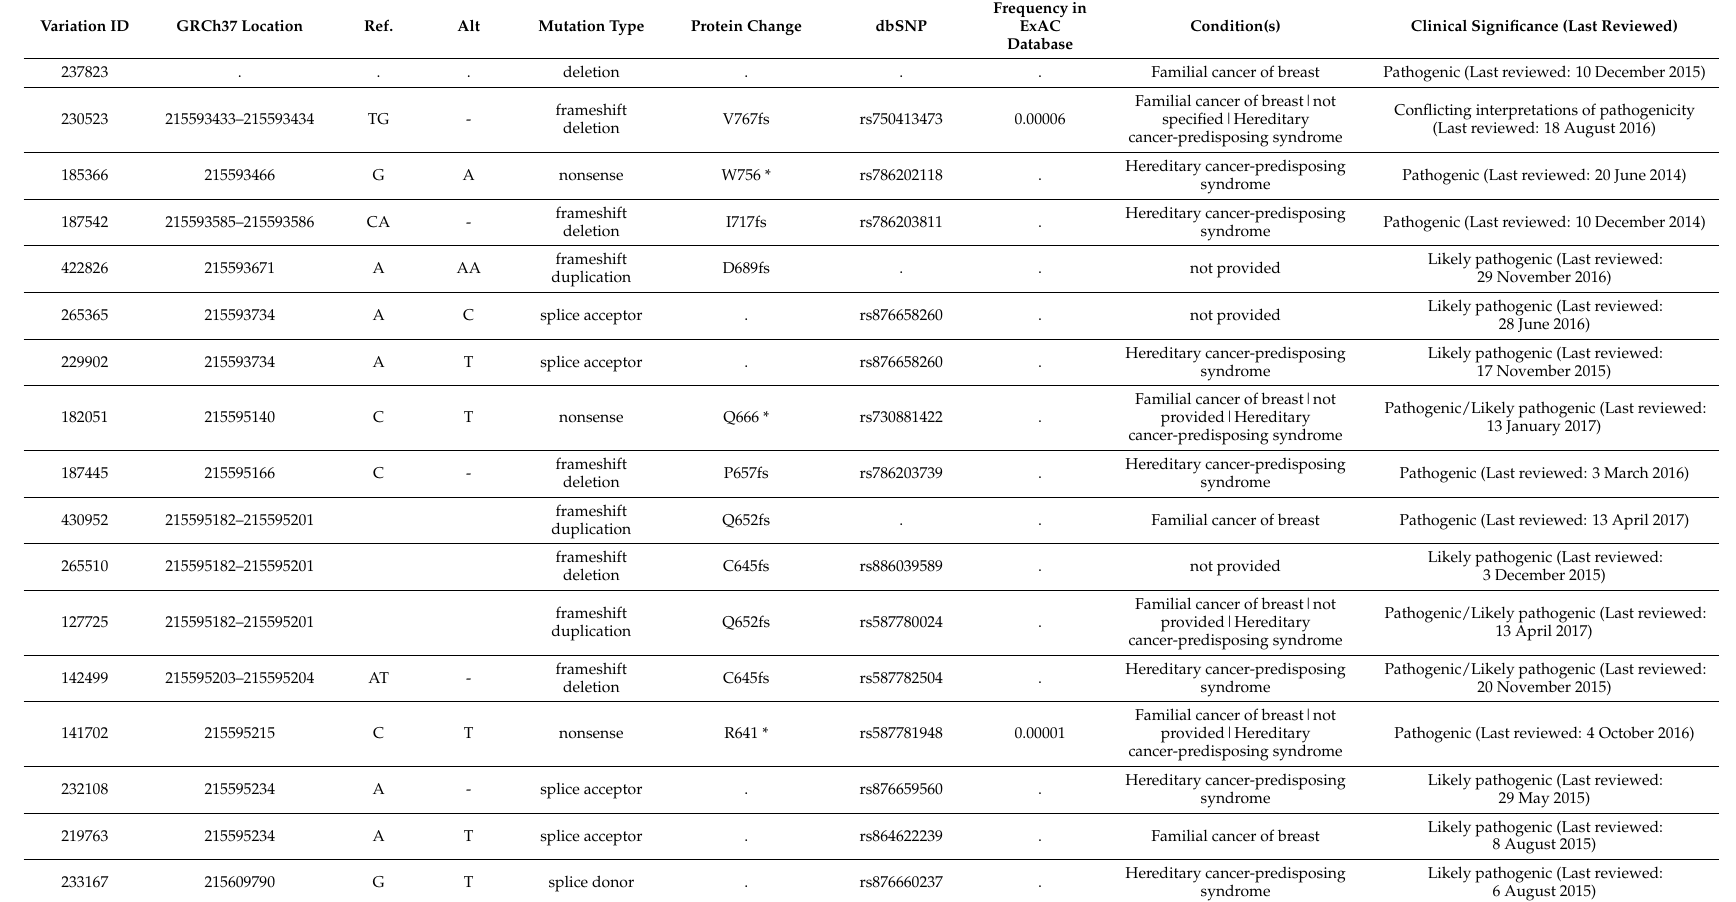
Table 1. Pathogenic and Likely pathogenic rare mutations of BARD1 reported in ClinVar